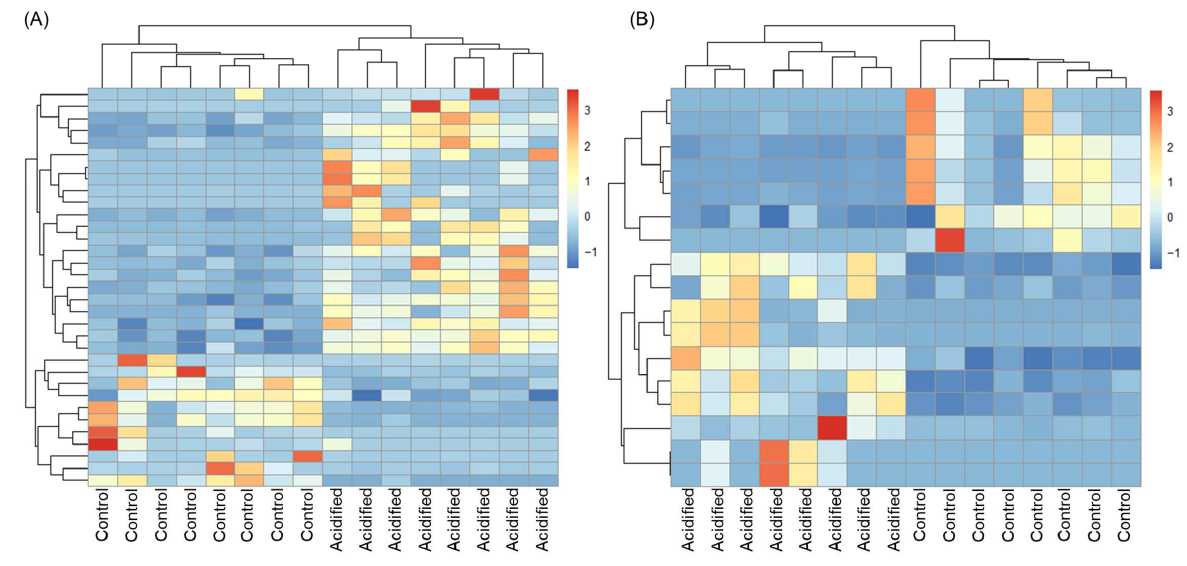
Figure 3. Hierarchical clustering analysis of differentially expressed genes. Over- and under- expressed genes are represented in red and blue, respectively. ( A ) Extrapallial fluid. ( B ) Hemolymph. Int. J. Mol. Sci. 2022 , 23 , x FOR PEER REVIEW Table 1. Differentially expressed genes in EPF and hemolymph from clams in OA vs. clams in con- trol conditions. Expression level corresponds to the OA treatment. Log2foldchanges (LFC) and ad- justed p -values (padj) for each DEG are given.